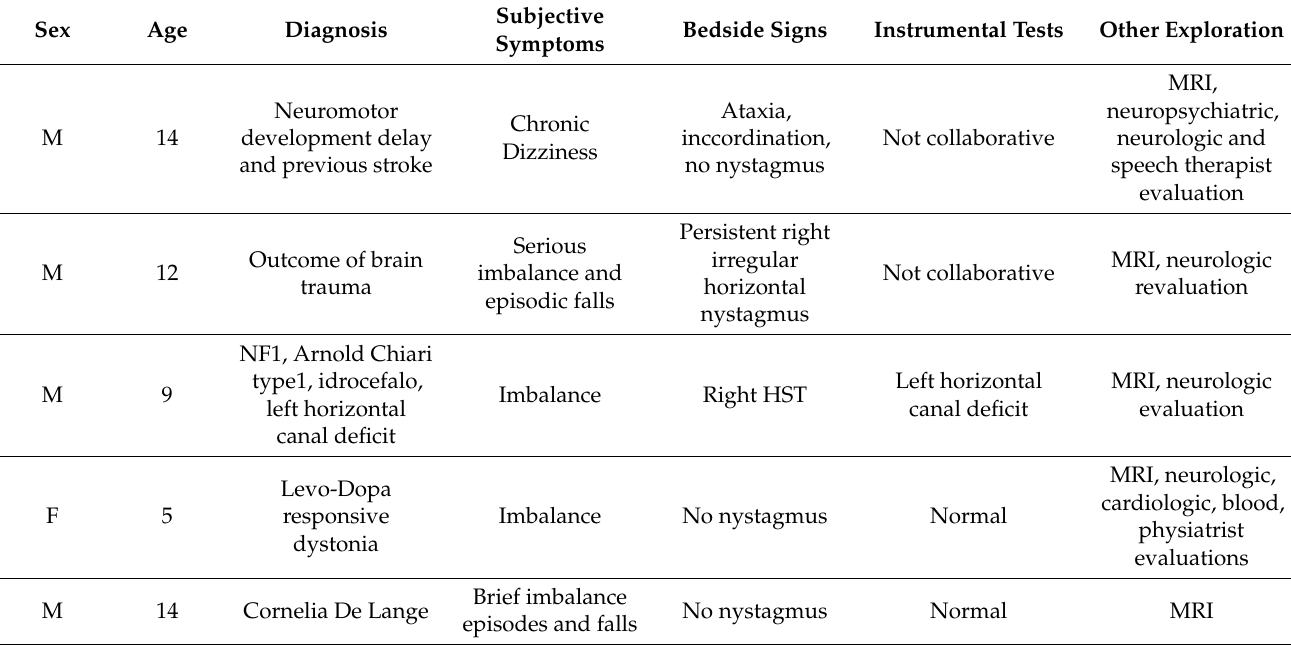
Table 2. Neurogenic diseases associated with vertigo in our